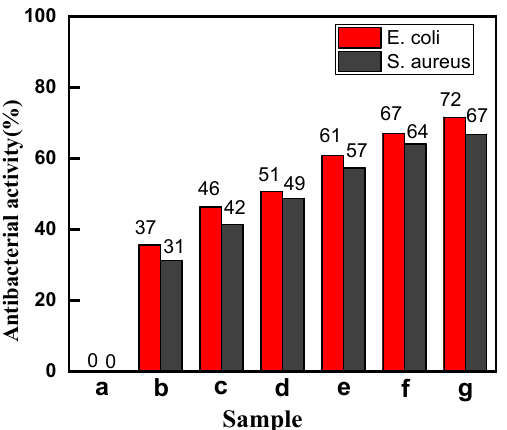
Figure 6. The antibacterial rates of the cotton fabrics (a, Raw; b, Direct; c, Mordant; d, CA; e, CA+TTA; f, CA+MLA; g, CA+SUA).